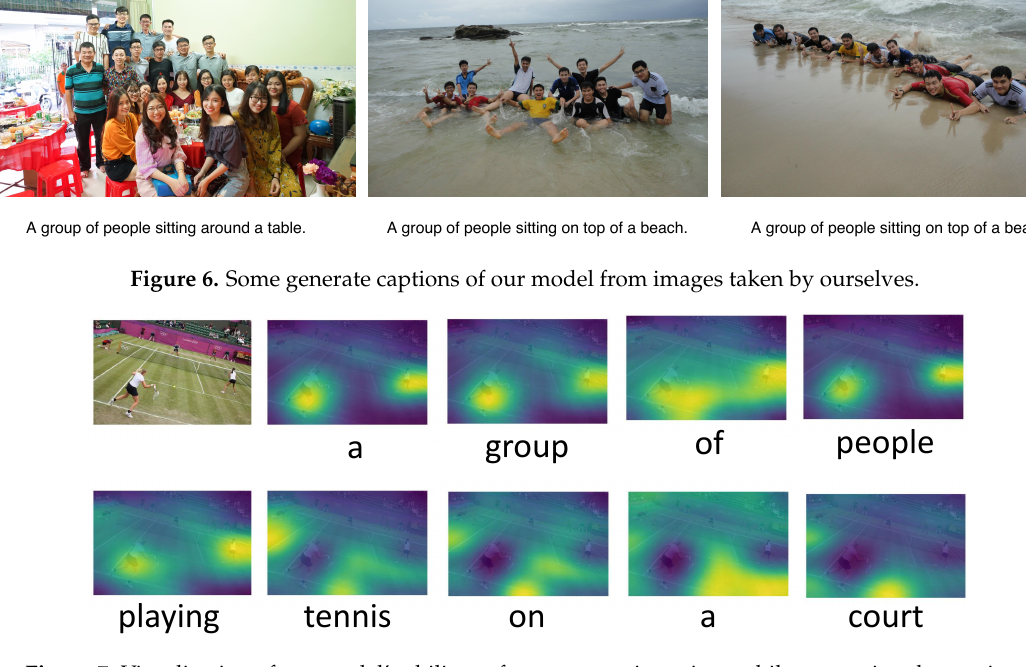
Figure 7. Visualization of our model’s ability to focus on certain regions while generating the